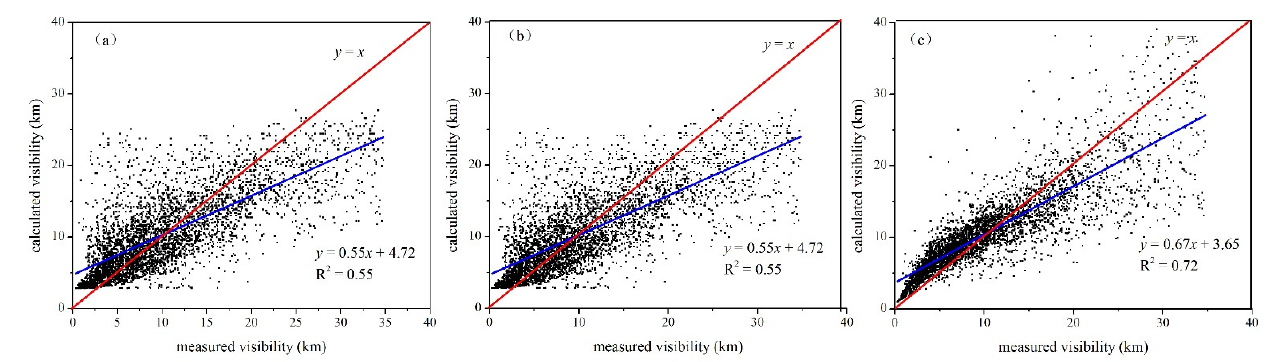
Figure 2. Comparison results calculated from regression equations and measured one-hour visibilities in Tianjin, 2015, with ( a ) 1-factor parameterization (Equation (1)) and ( b , c ) 2-factor parameterization (Equations (2) and (3)) at 95% confidence level; the 1:1 line is in red, and the linear fit line is blue.